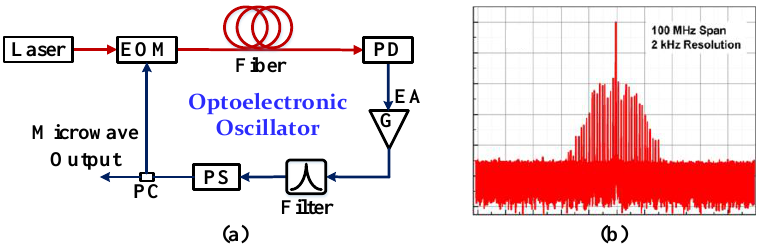
Figure 1. ( a ) The schematic diagram of a fundamental optoelectronic oscillator (OEO). EOM: electro-optical modulator. PD: photodetector. EA: electronic amplifier. PS: phase shifter. PC: power coupler. ( b ) The example spectrum of fundamental optoelectronic